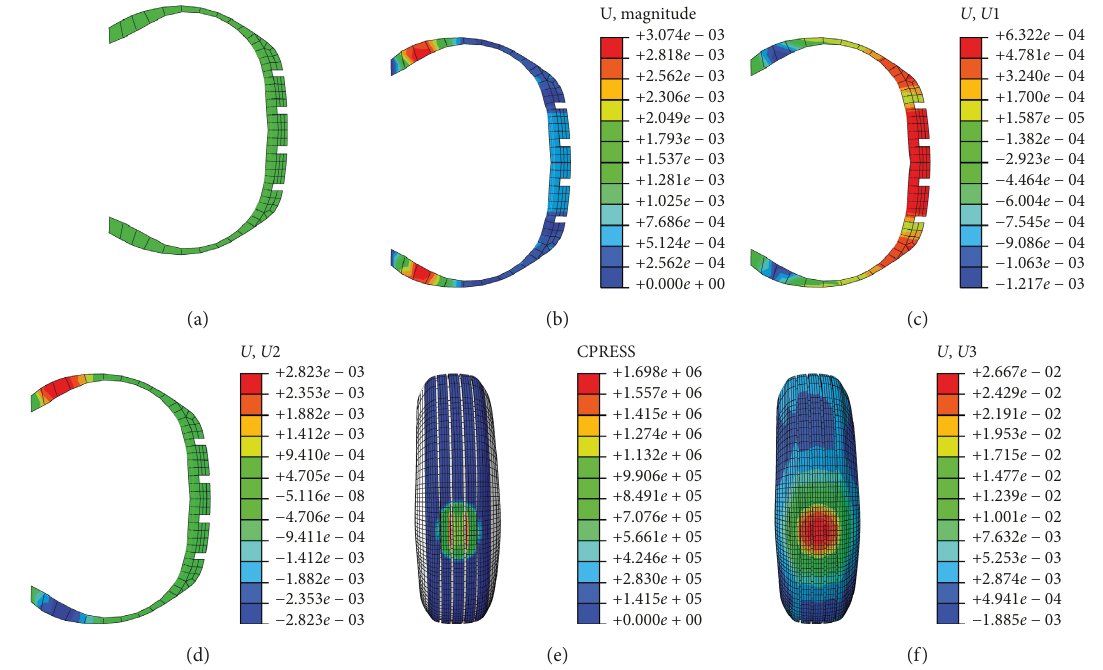
Figure 2: Stress and strain nephogram of the tire-pavement contact model. (a) The two-dimensional cross-section mesh of tire. (b) Dis- placement nephogram of the inflated tire rubber materials. (c) Displacement nephogram of U 1 along the tread. (d) Displacement nephogram of U 2 along the sidewall. (e) Pressure distribution of the tire contact region. (f) Displacement nephogram of U 3 of the tire contact region.